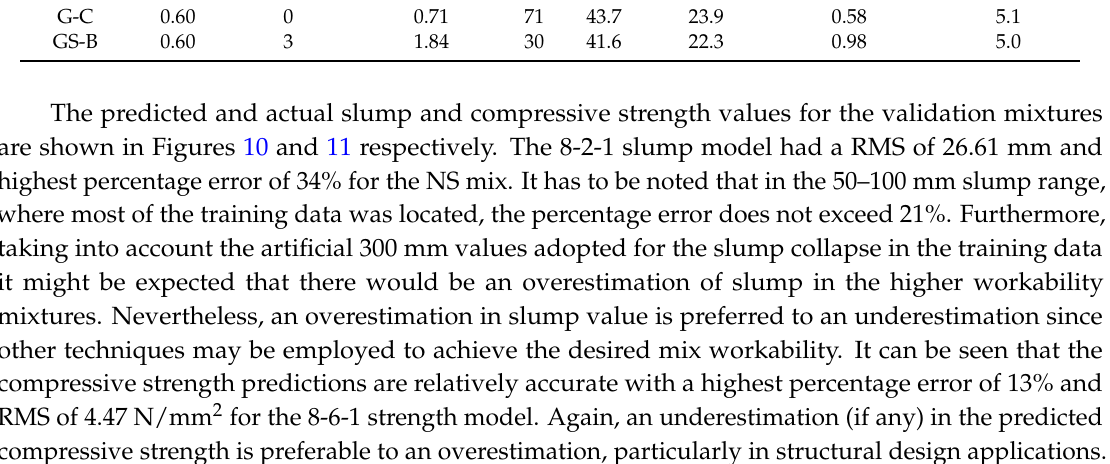
15 of 19 Table 8. Validation mixture input values. Validation Mix